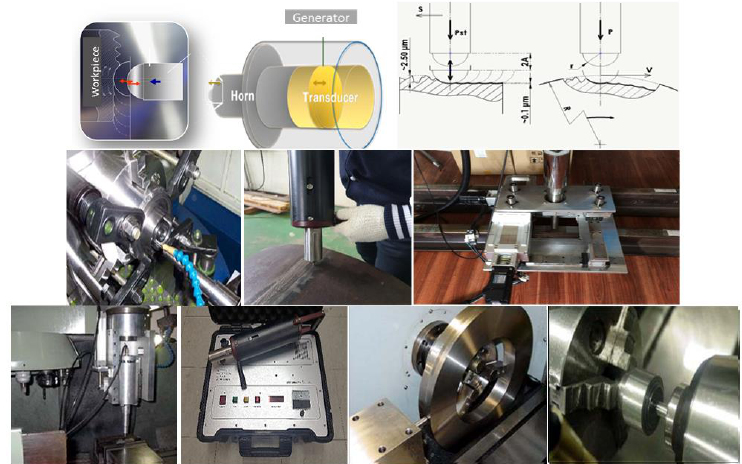
Figure 5. Mechanism and industrial applications of the UNSM process. Metals 2019 , 9 , x FOR PEER REVIEW